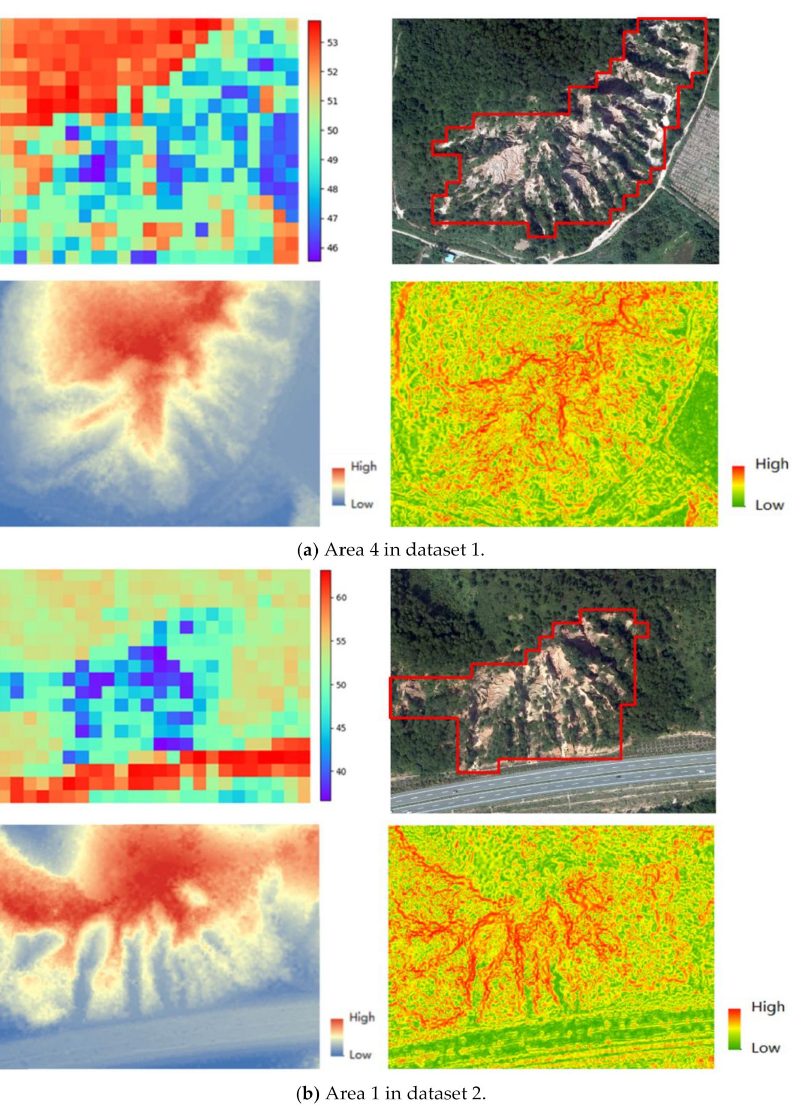
Figure 8. Visualization of the effects of DOM and DSM on detection results. ( Top left ) Influential score for each grid cell (0–100, with higher scores indicating large influences of DOM features). ( Top right ) Corresponding image showing the boundaries of benggang areas. ( Bottom left ) Shaded relief map. ( Bottom right ) Slope